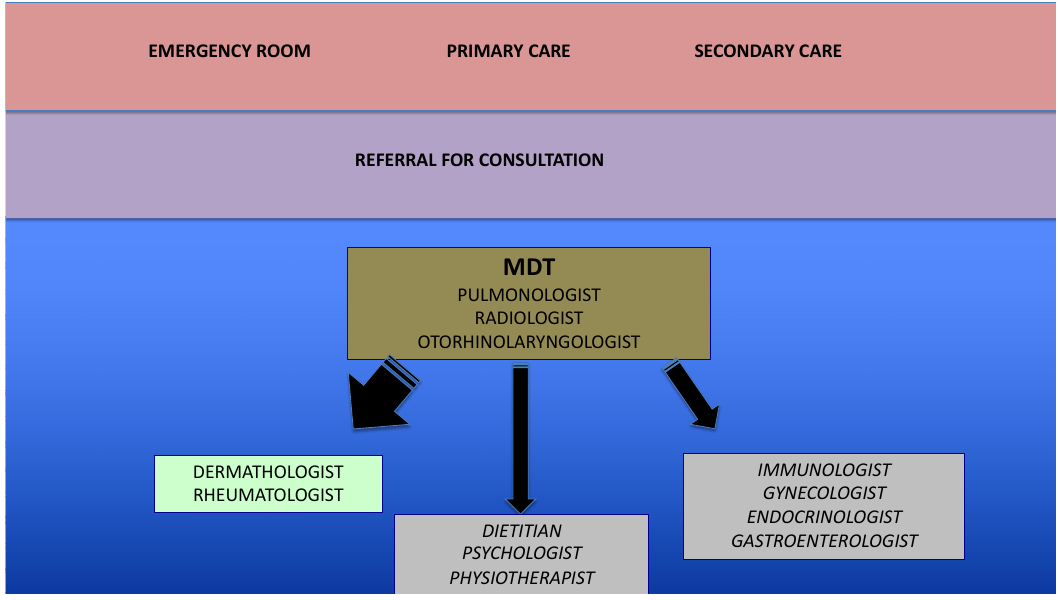
Figure 1. Sta ff and specialties involved in a severe asthma service with a multidisciplinary approach. The dimensions of the arrows indicate the frequency of consultations.